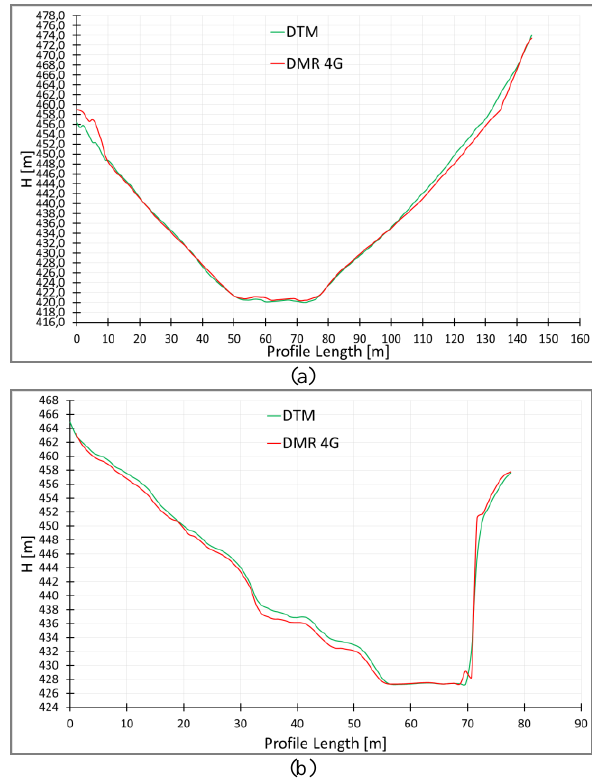
Figure 6. Visual profile comparison of DMR 4G and robust moving planes DTM (a) data set 1 (b) data set 2